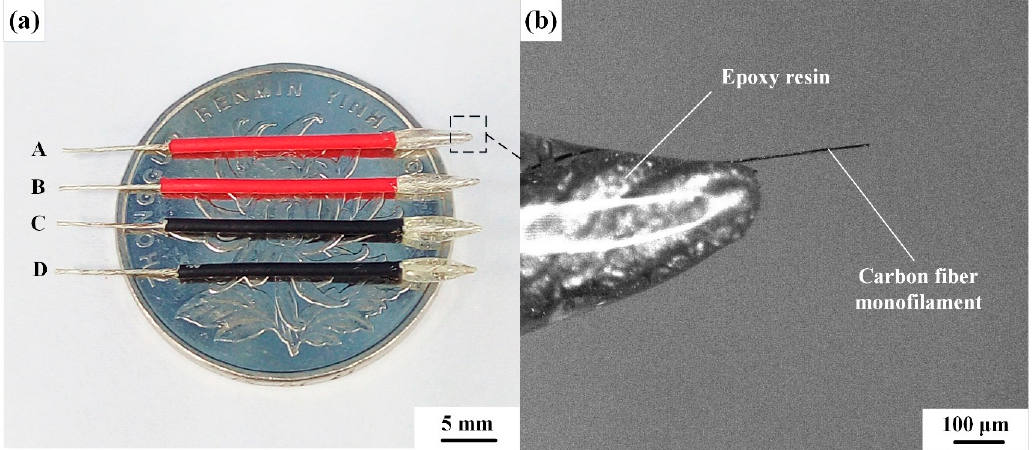
Figure 4. ( a ) Picture of the actual microelectrodes fabricated. A–D is CFME-T0, CNTs/CFME-T5, CNTs/CFME-T10, and CNTs/CFME-T15, respectively; ( b ) Magnified image of the protruding electrode.